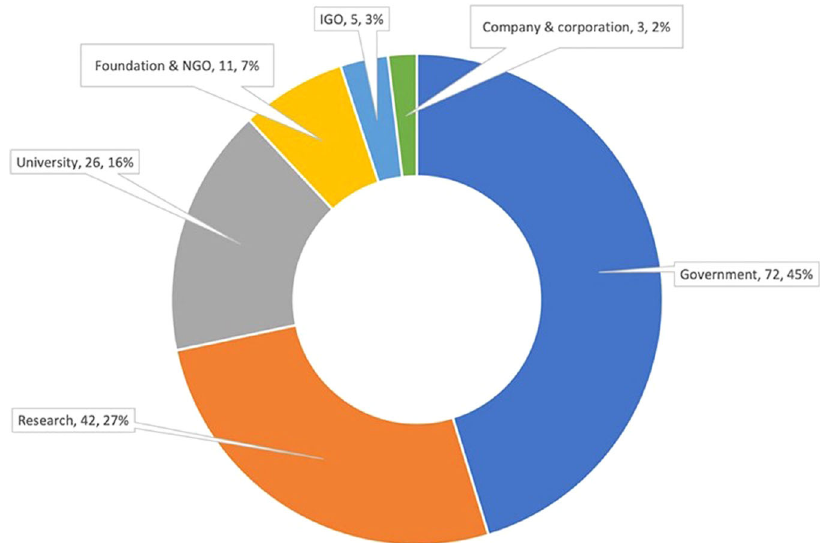
Fig. 8 Types of funders of rice research in Indonesia and the Philippines since 2001, n = 159 funders. The majority of rice research projects in Indonesia and the Philippines were funded by governments (45%), research (27%), and university institutions